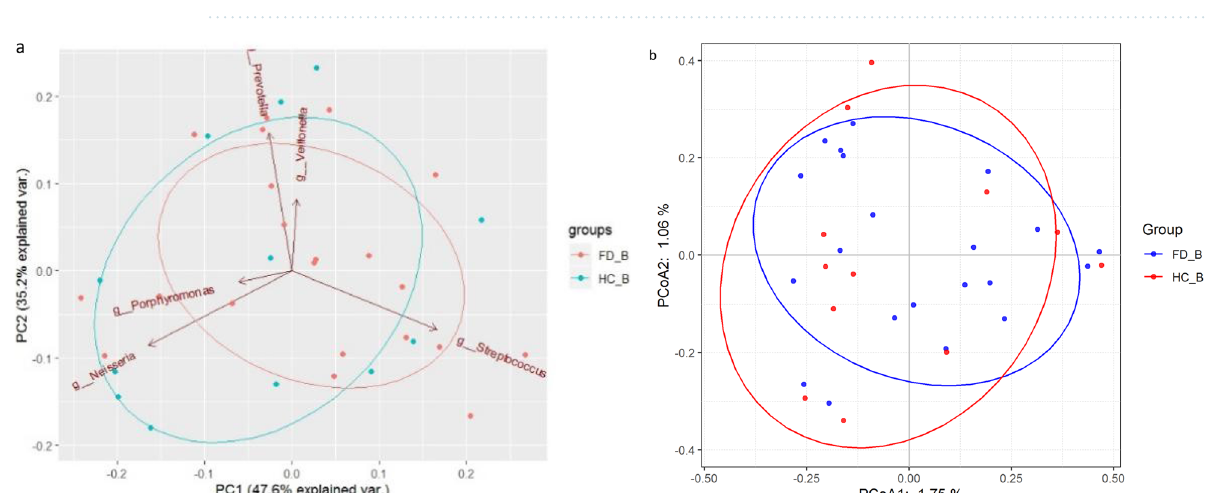
Figure 2. Comparison of the phylogenetic structure and composition of microbial communities between the FD group and HC group. ( a ) Principal Component Analysis (PCA) based on the Bray–Curtis dissimilarity is shown for FD (red) and HC (blue). ( b ) Principal coordinate analysis (PCoA) based on unweighted UniFrac distances is shown for FD (blue) and HC